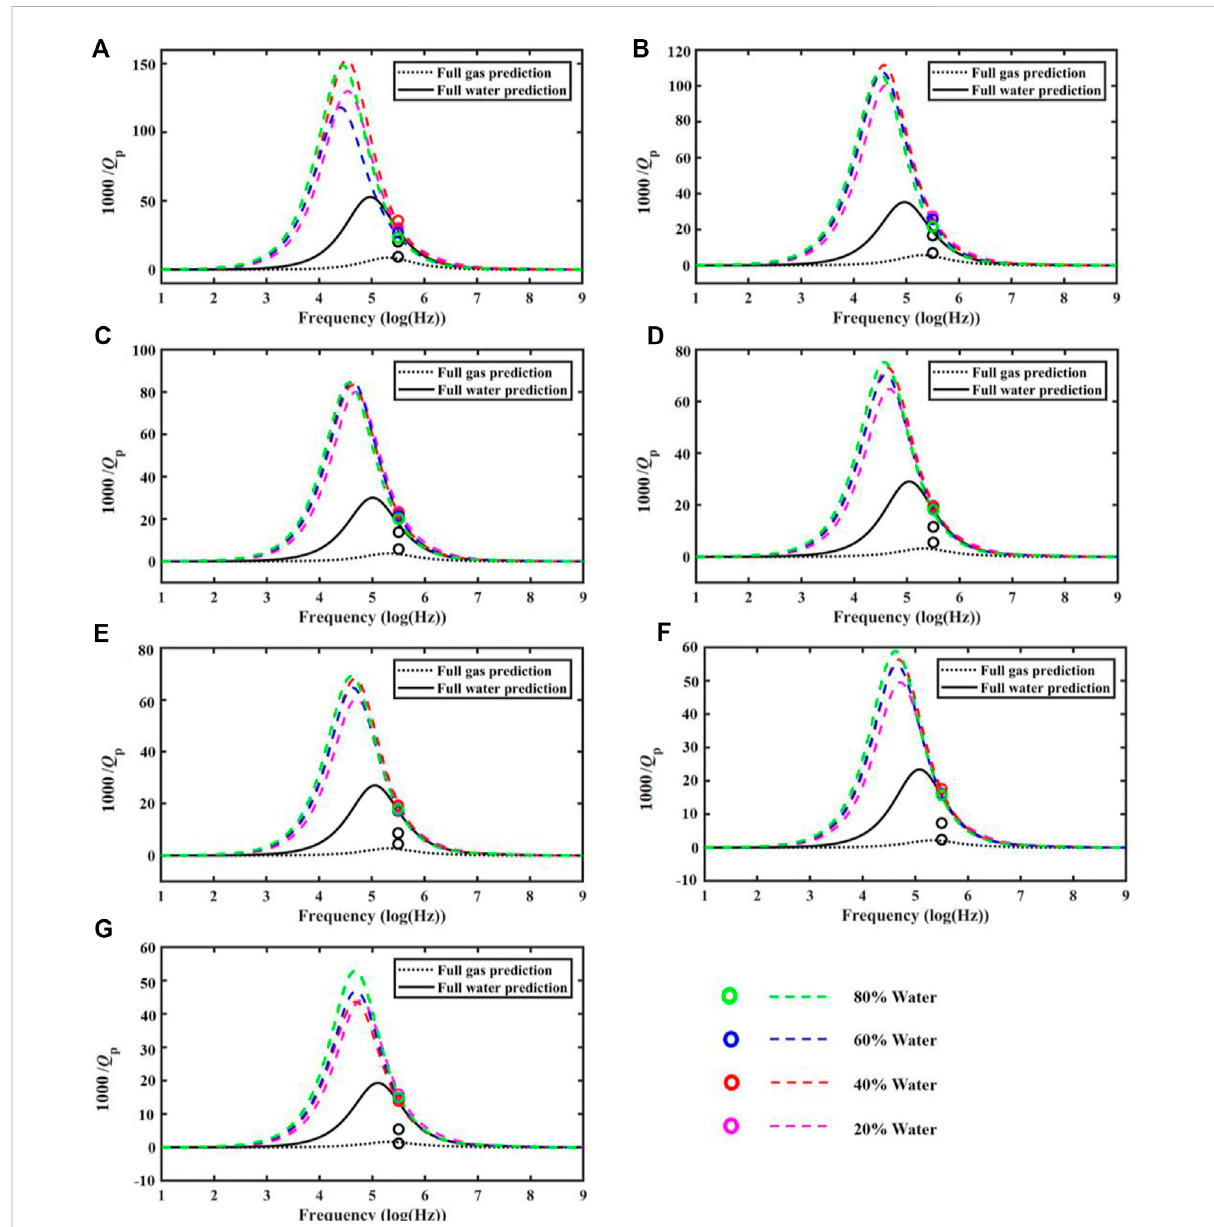
FIGURE 11 P-wave dissipation factor frequency dependence for sample 1 – 19 at5 MPa (A) , 10 MPa (B) , 20 MPa (C) , 30 MPa (D) , 40 MPa (E) , 50 MPa (F) and 60 MPa (G) . The experimental data are shown as circles.